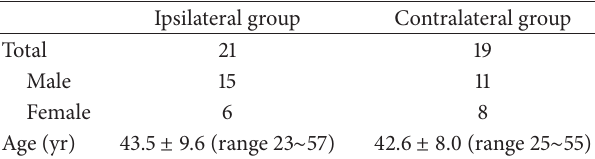
Figure 2: Patient with contralateral abdominal pocketing. Table 1: Demographic data of patients included in the